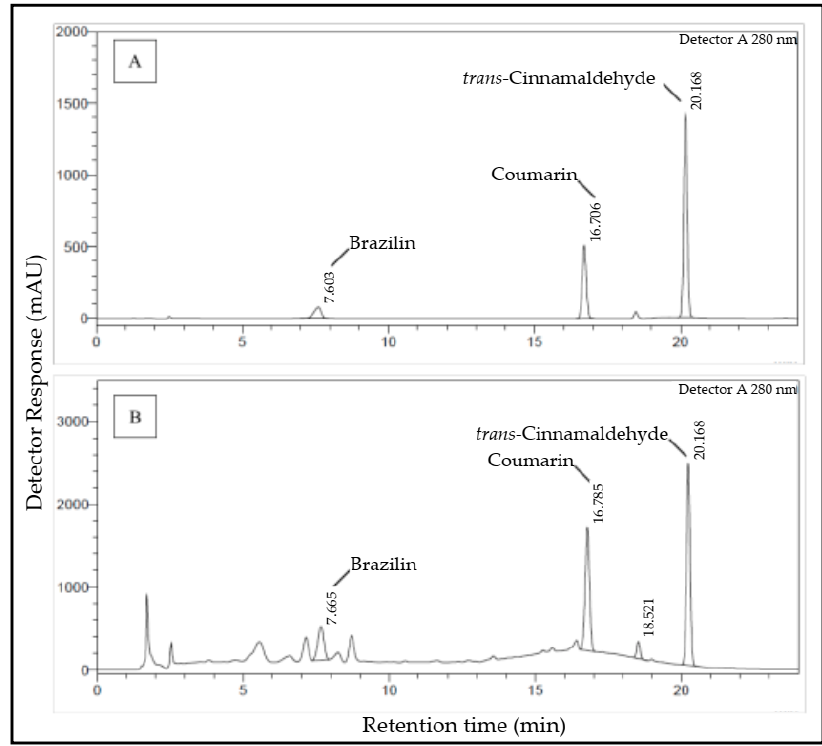
Figure 2. Chromatogram shows ( A ) a 100 µg/mL mixture of brazilin, coumarin, and trans -cinnamaldehyde standard, and ( B ) an NADES extract combination of cinnamom bark and sappan wood.